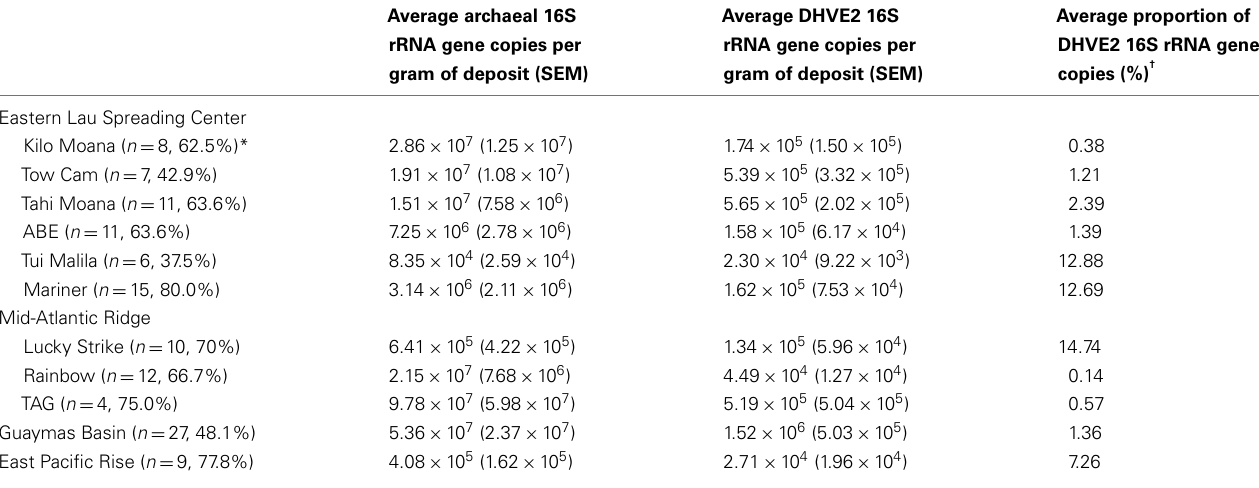
Table 2 | Results of qPCR assays to determine the occurrence and relative abundance of the DHVE2 in hydrothermal vent deposits collected between 2006 and 2009 from several different vent